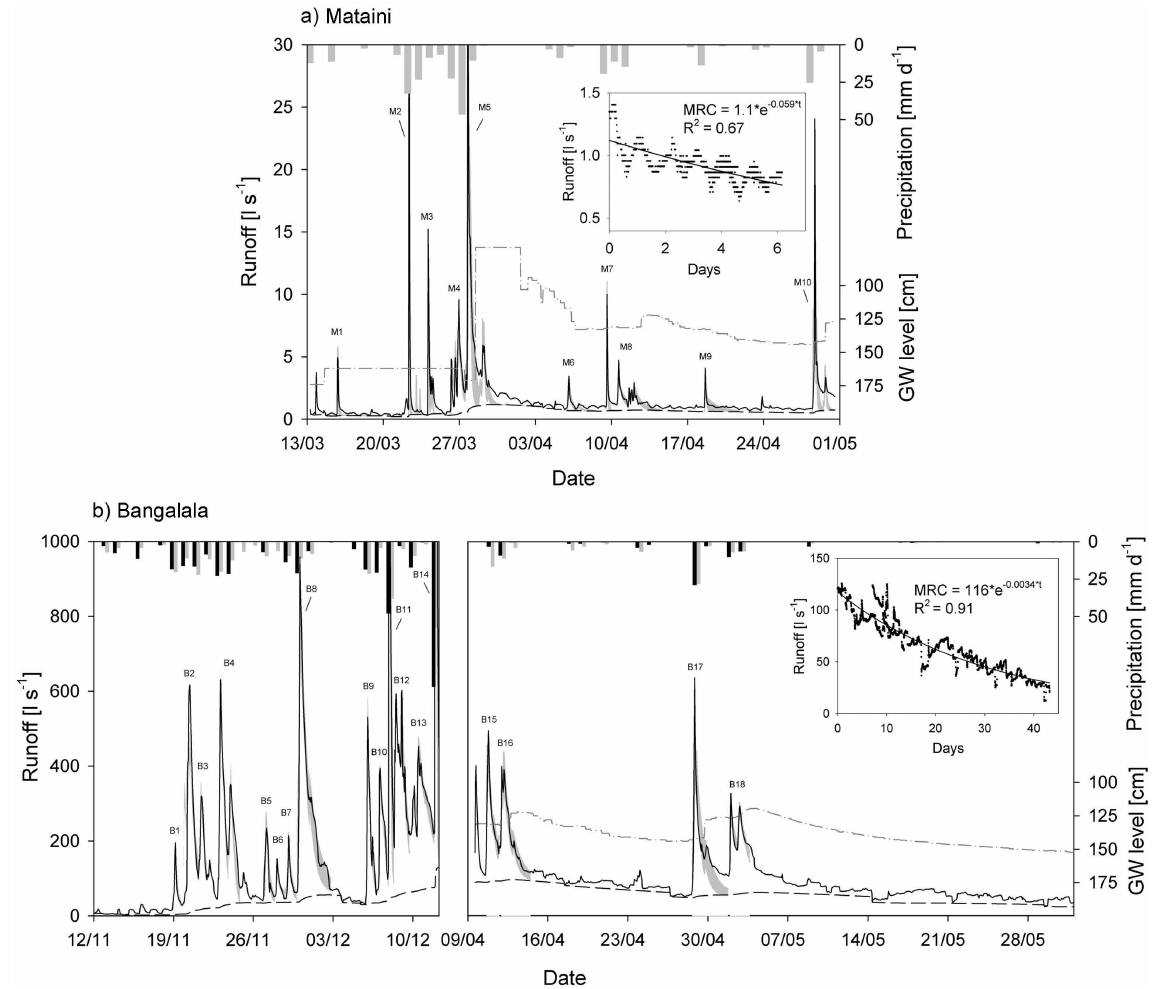
Fig. 2. Observed times series of precipitation, stream flow (-) and groundwater level (-.-), as well as the modeled time series for baseflow (–) and the modeled 95% uncertainty interval of direct flow (grey shaded area) for (a) the Mataini catchment and (b) the Bangalala catchment. M1–M10 and B1–B18 denote the defined precipitation and runoff events in Mataini and Bangalala, respectively.